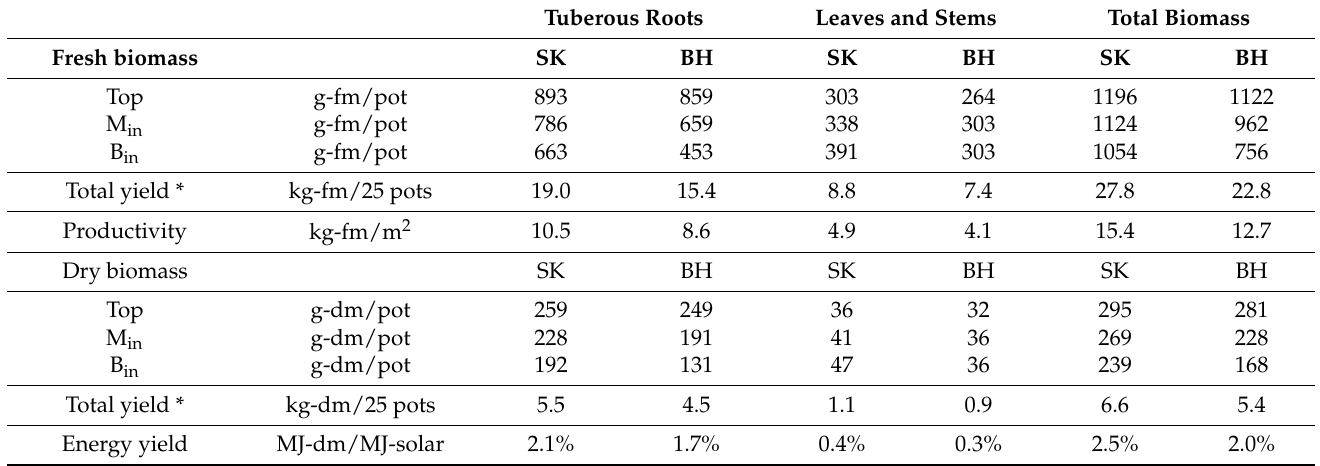
shows the dry weight. Table 1. Productivity of sweet potatoes in three-layer cultivation and energy yield to the solar radiation.